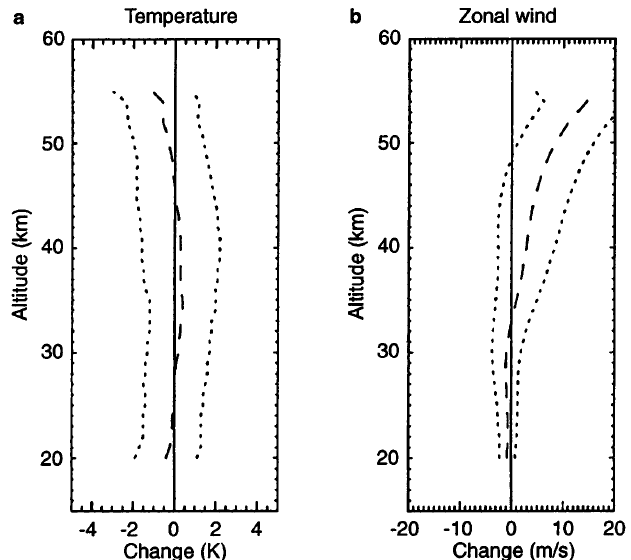
Fig. 1a, b. Amplitude of step functions ( dashed lines ) as a function of altitude in a the temperature and b wind data series computed with the regression model respectively in January 1977 and April 1975. Dotted lines are the 2 r confidence intervals. Changes are shown for temperatures in K and in ms ) 1 for wind